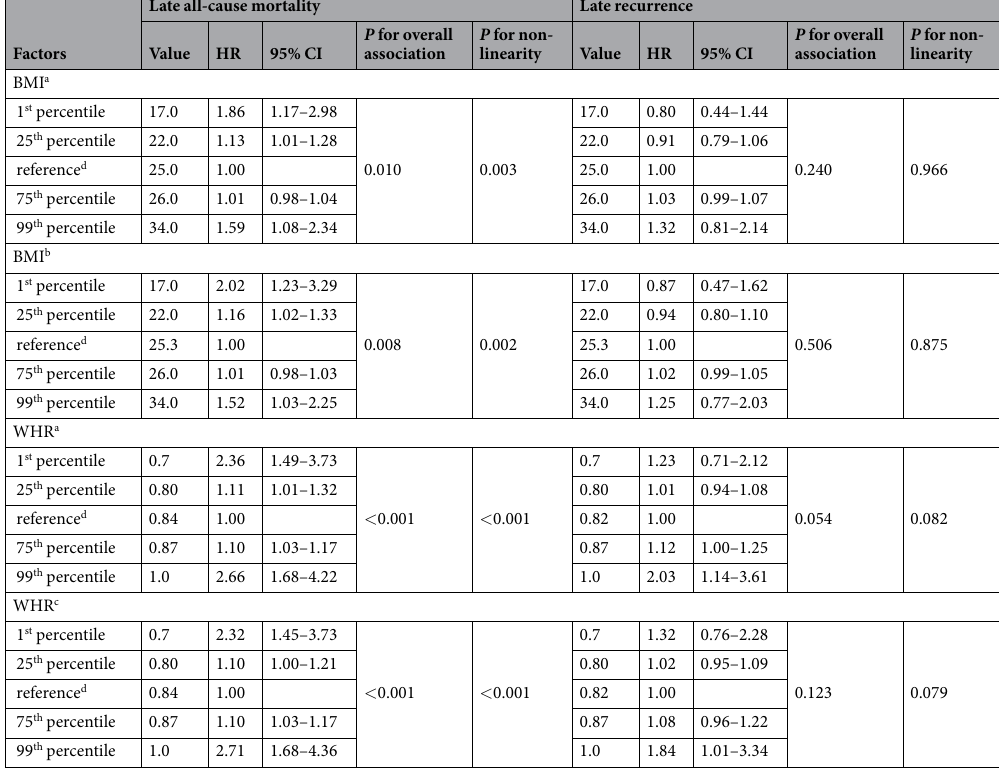
Table 3. Hazard ratios and 95% confidence intervals for post-diagnosis BMI and WHR in association with late all-cause mortality and recurrence of breast cancer, the Shanghai Breast Cancer Survival Study. a Adjusted for age at diagnosis, soy protein intake, ER status, TNM stage, mastectomy, chemotherapy, radiotherapy, regular exercise, comorbidity, education and menopausal status. b Additionally adjusted for WHR as a continuous variable. c Additionally adjusted for BMI as a continuous variable. d Using the BMI or WHR value with the lowest hazard as reference.